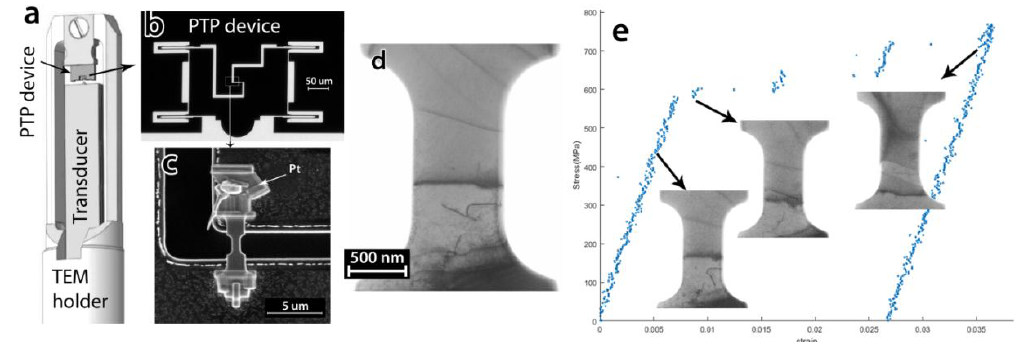
Figure 10. ( a ) Schematic of the PicoIndenter holder; ( b ) TEM BF image of a PTP device; ( c ) SEM image of a tensile sample mounted on a PTP device; ( d ) TEM BF image of a FIB near-defect-free single crystal Ni sample containing only a few dislocations, and ( e ) engineering stress-strain curve of the single crystal Ni sample, the images in the insets are snapshots from the recorded deformation movie, corresponding to the points at the arrows’ origin. Note the strain bursts induced by the operation of the individual SAS (single arm source).